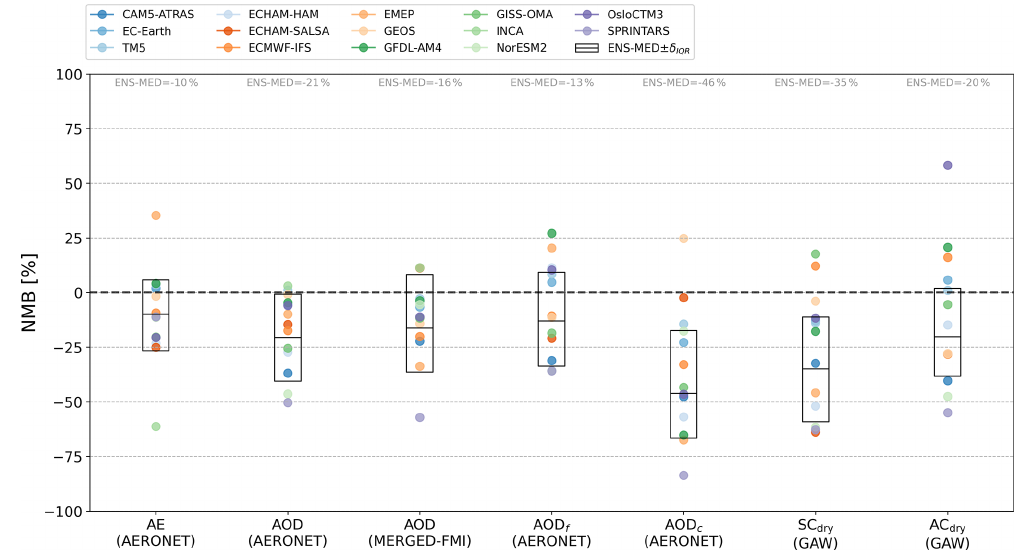
Figure 6. Summary of results from comparison of models with ground-based observation networks and MERGED-FMI satellite AOD data set. The y axis indicates the retrieved biases (NMBs) for individual models (indicated as circles). The black boxes indicate results from the ensemble median (ENS-MED), together with the associated spread ( δ IQR